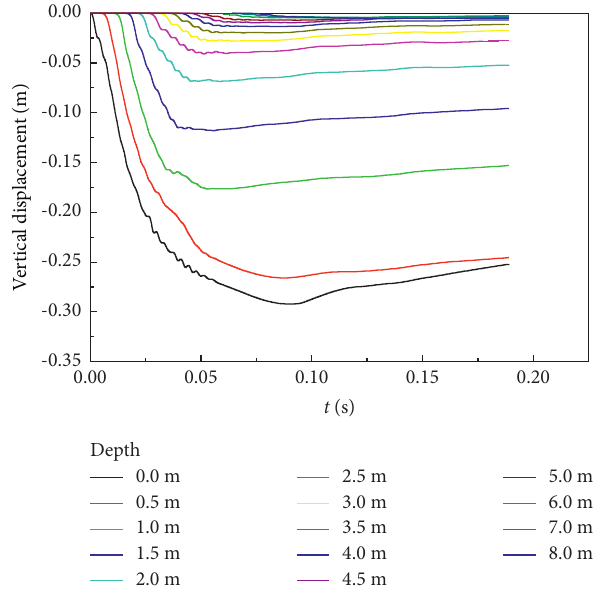
r=1.94 Figure 18: The trajectory of particle at 1.94 m from the centre of